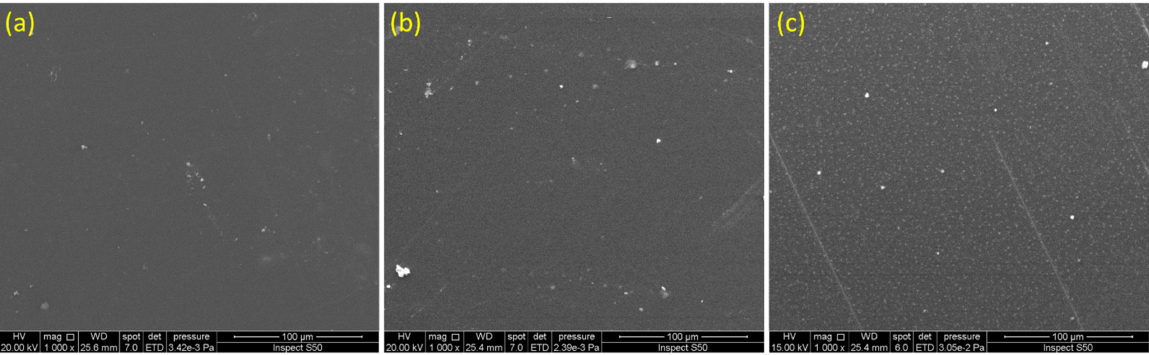
Figure 8. SEM images recorded after 300 h of irradiation of PS films containing ( a ) ibuprofen–Mn complex, ( b ) ibuprofen–Co complex, and ( c ) ibuprofen–Ni